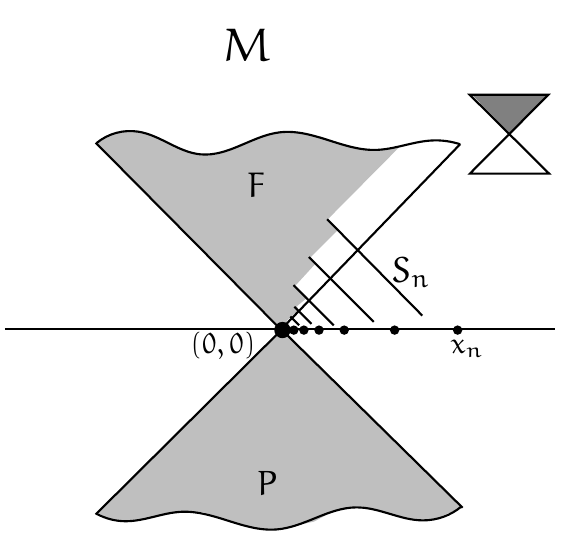
Figure 7 . Let M be L 2 with the segments S n removed. On this example, the sets P and F are S -related and the sequence f x n g n has ( P; F ) on its limit. However, for n big enough, the timelike curves from x n to points in F should pass between S n and S n + 1 . In particular, if f p n g n (cid:26) f 0 g (cid:2) M is a lift of f x n g n , and F is the corresponding lift of F in f 0 g (cid:2) M , then g F 6(cid:26) LI ( f I + ( p n ) g n ) for any g 2 G